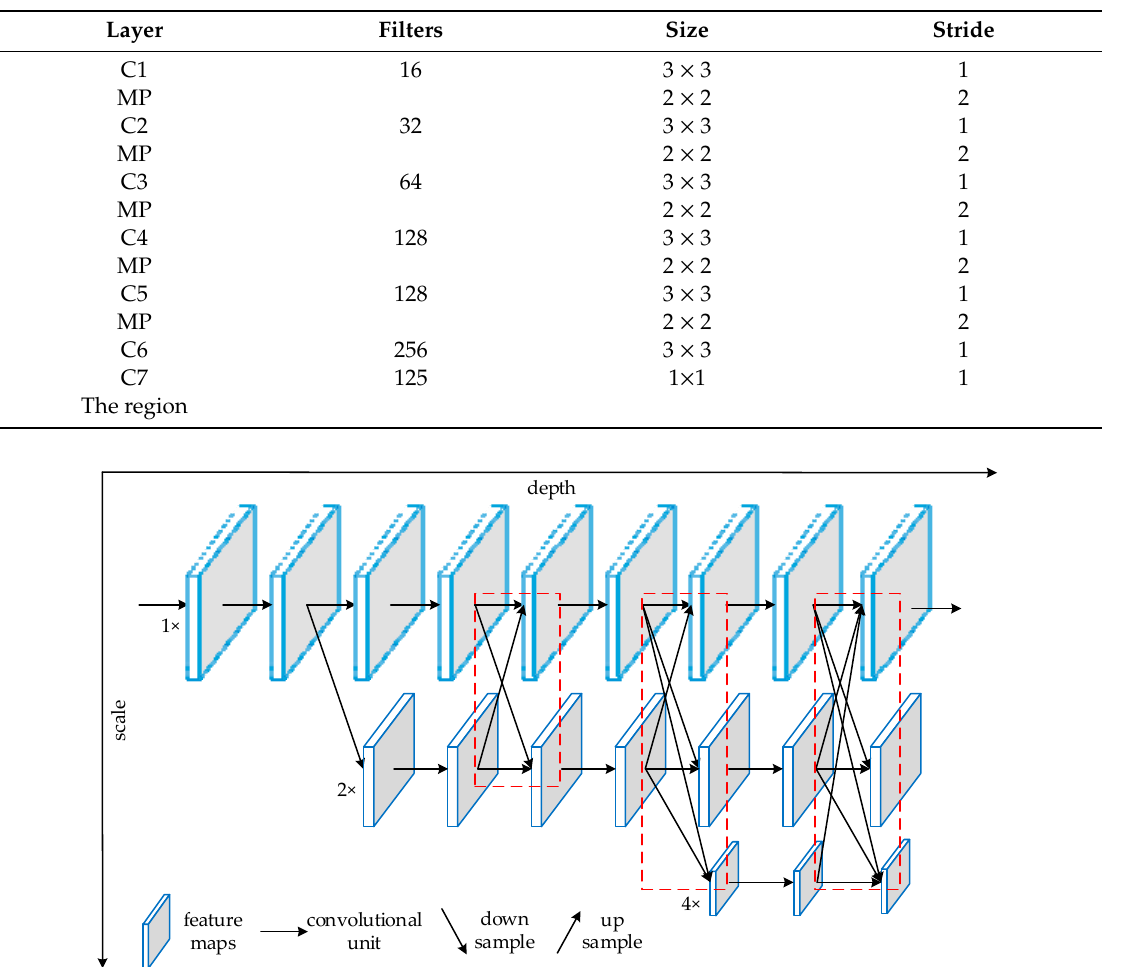
Figure 3. Schematic illustration of the architecture of the high-resolution network (HRNet).